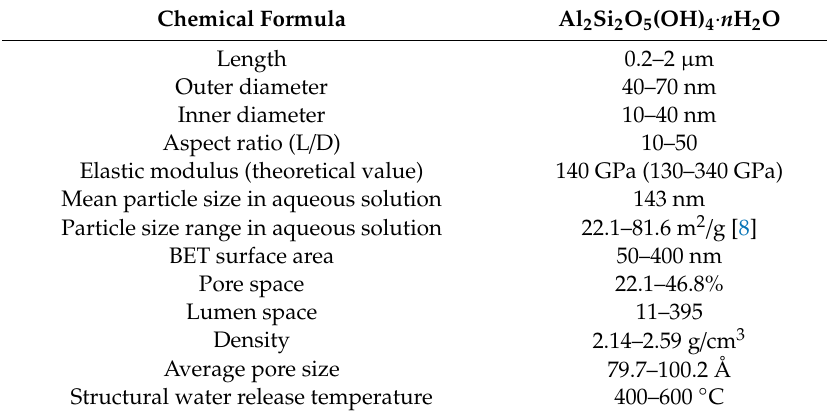
Table 1. Physico-chemical features of halloysite nanotubes (HNT)s.